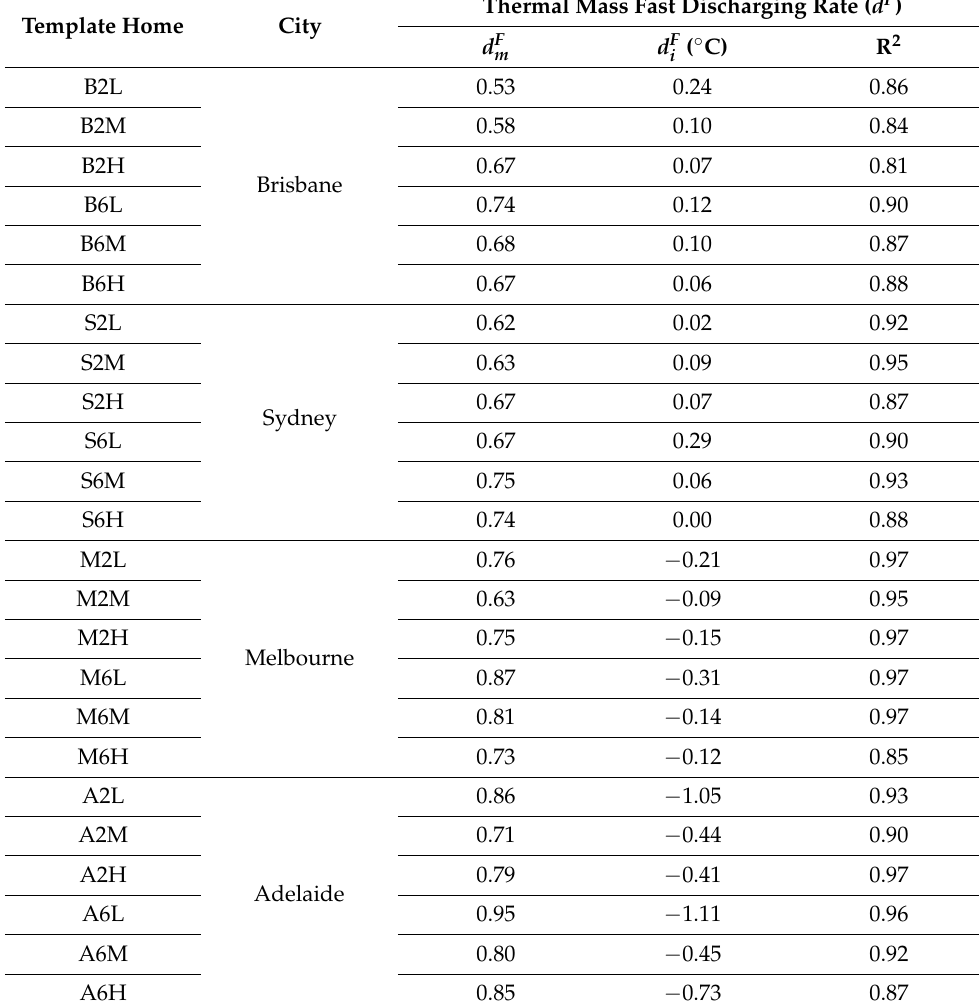
Table A4. Thermal mass fast discharging